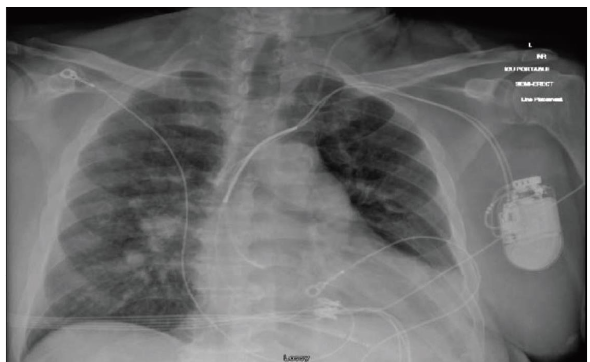
Figure 1: Chest X-ray.